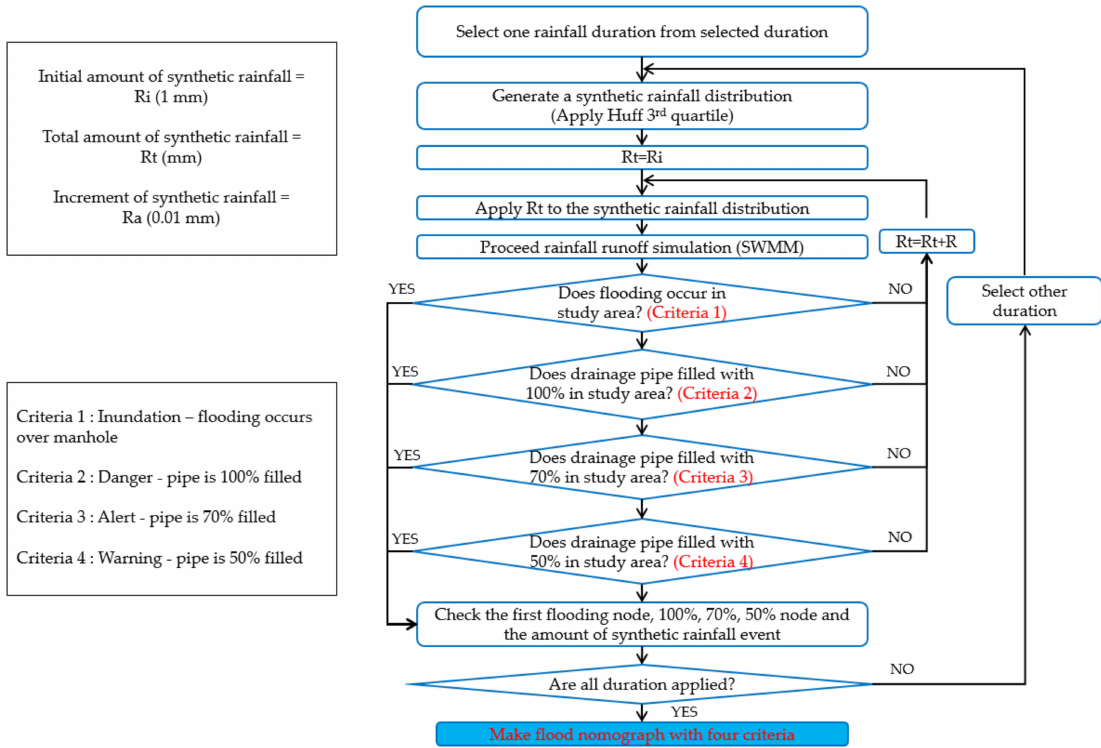
Figure 3. Improved flood nomograph flow diagram (with four